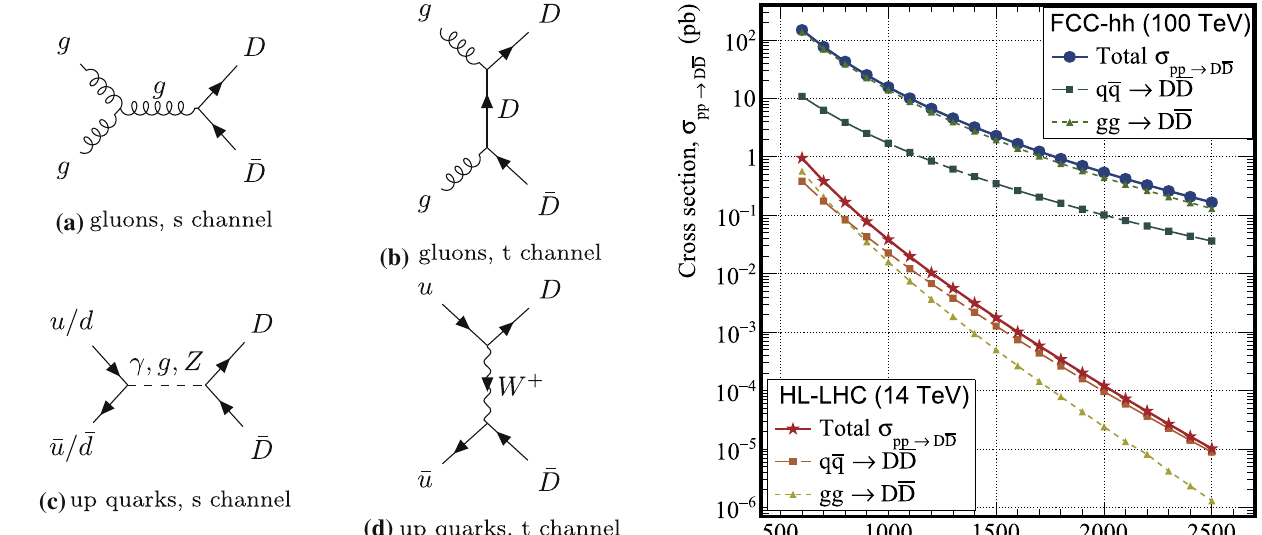
experimental reach at both HL-LHC and FCC-hh